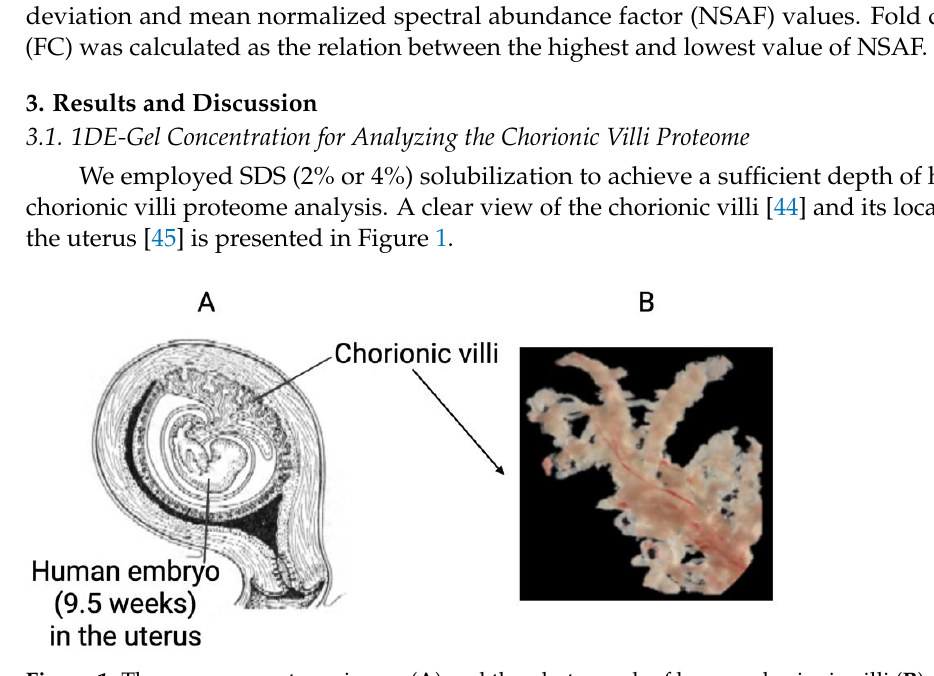
Figure 1. The pregnancy uterus image ( A ) and the photograph of human chorionic villi ( B ).